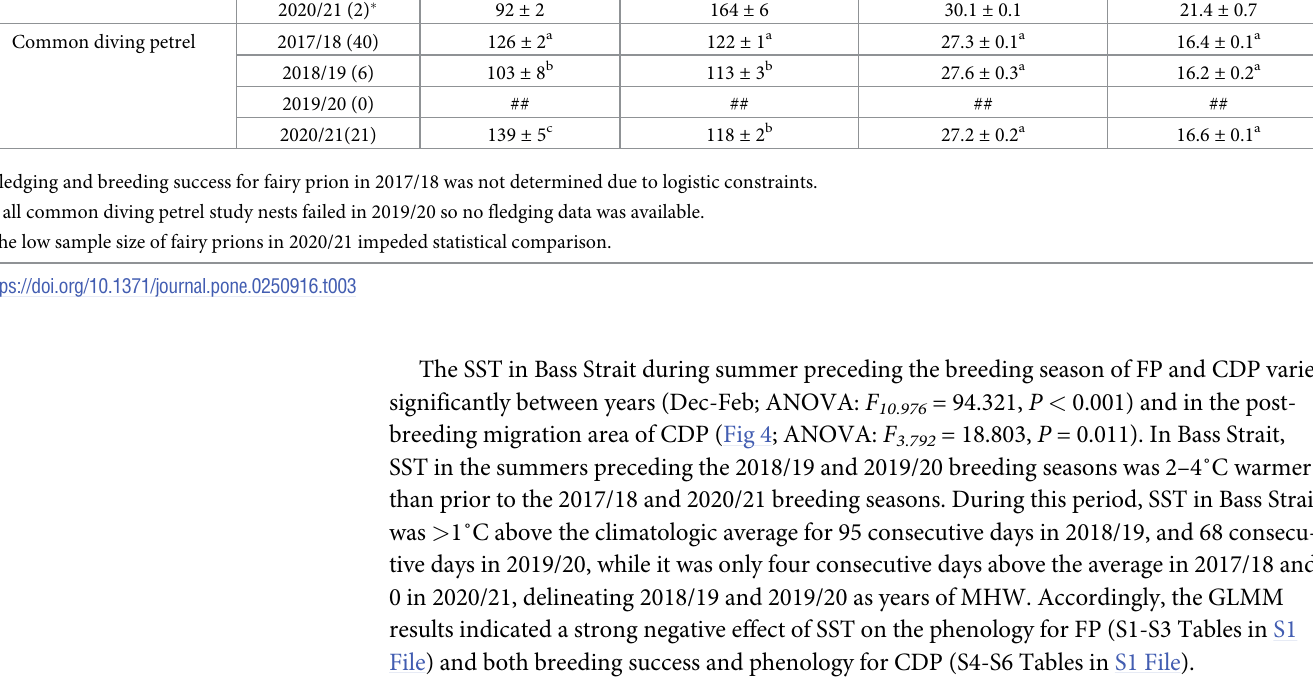
Table 3. Body mass, wing length, tarsus length, and bill length (mean ± SE) of fairy prion ( Pachyptila turtur ) and common diving petrel ( Pelecanoides urinatrix ) fledglings from Kanowna Island, Bass Strait, south-eastern Australia. For each period/species, values not sharing the same superscript letter (a, b, or c) are significantly different (Mann-Whitney U test: P < 0.05). Sample sizes are provided in parentheses.